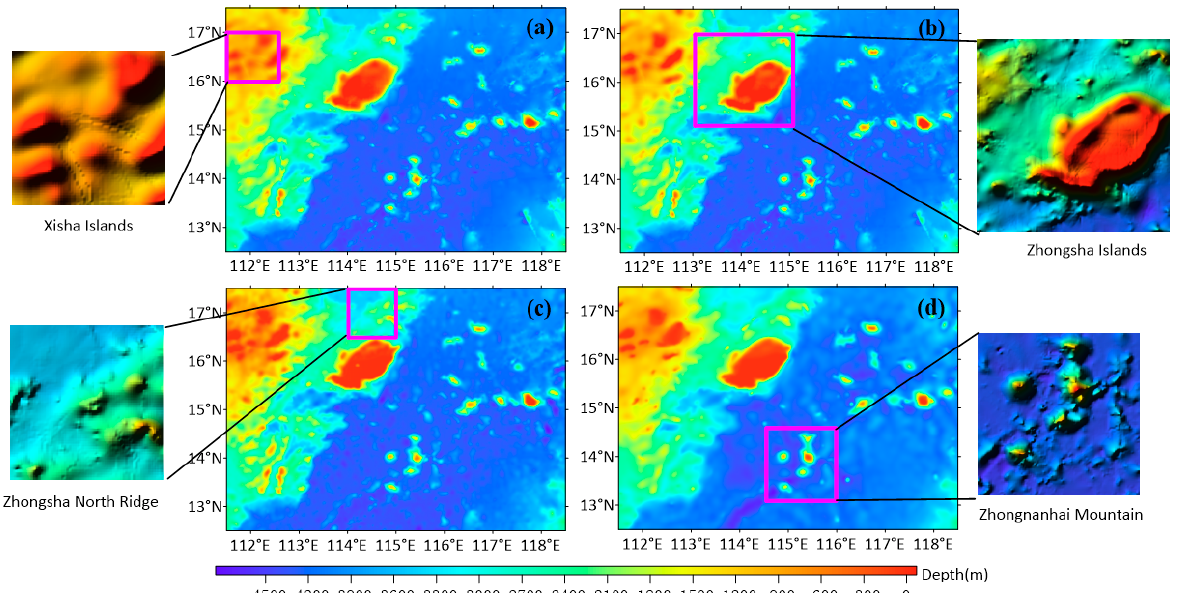
10 of 17 Figure 6. Flowchart of the seafloor topography inversion process. First, the pre-processed discrete SSD were gridded using the Kriging interpolation. Then, the seafloor topographic grid and gravity anomalies were filtered to obtain data in different wavelength ranges. Second, bilinear interpolation was used to obtain filtered gravity anomalies and SSD at the position of the control points, respectively. Subse- quently, a linear regression was fitted based on the least-squares method. The fitted pa- rameters were also used to invert the initial seafloor topography in the medium wave- length ranges with the filtered gravity anomalies. Finally, the initial model was corrected using Equation (4) and the final seafloor topography was constructed by adding the long wavelength topography component of the SIO 24.1 seafloor topography to the corrected topography based on Equation (5). The result is shown in Figure 3a. In addition, to avoid